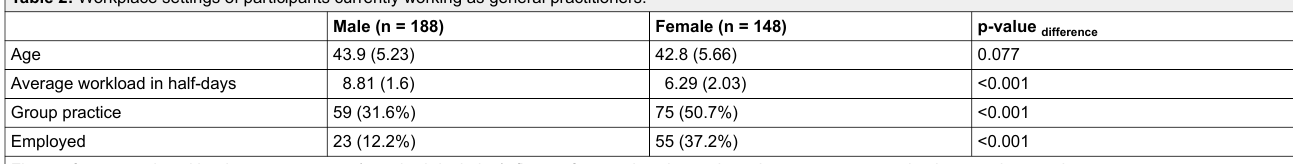
Table 2: Workplace settings of participants currently working as general